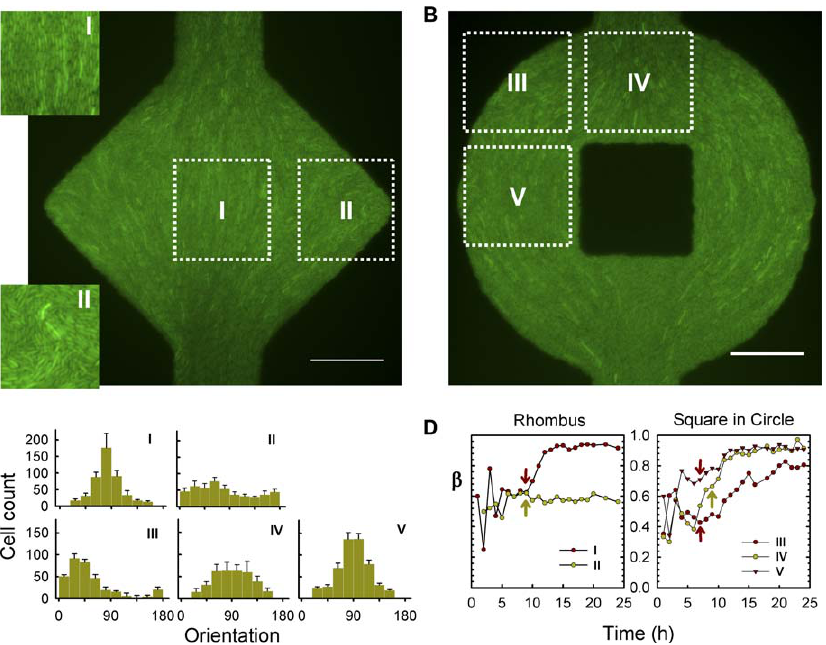
Figure 3. Colony Self-Organization in Chambers of Different Geometries Colony self-organization in various regions in the chambers of two geometries: rhombus (A) and square in circle (B). The images of the chambers were obtained in the same experiment as in Figure 1 (Videos S4–S8). (C) The histograms of the steady state cell orientations in the selected regions based on major axis analysis as in Figure 1. (D) Time-dependence of the fraction, b , of cell population oriented within 45 8 of the preferred cell orientation in selected regions: I- 90 8 ; II- 90 8 ; III- 45 8 ; IV- 90; V- 90 8 with respect to x -axis. The arrows indicate when the colony becomes densely packed. Scale bars: 50 l m.